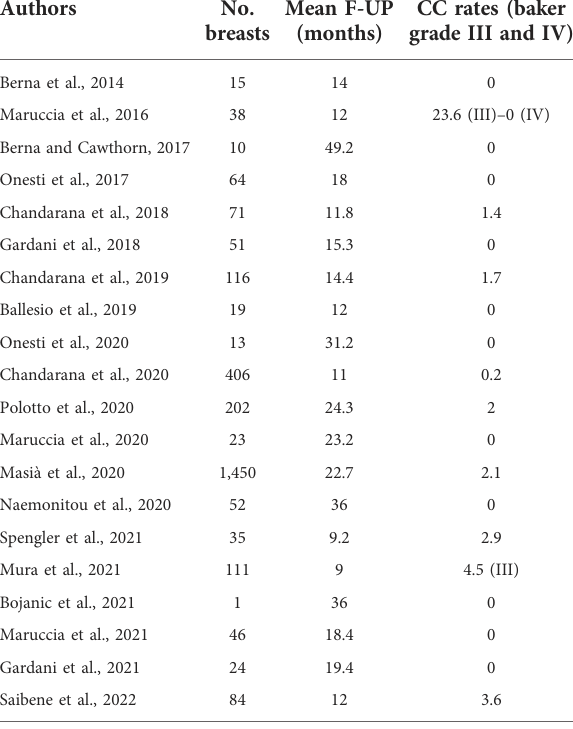
TABLE 4 List of the Braxon®-speci fi c published articles in which the CC rates are speci fi ed.